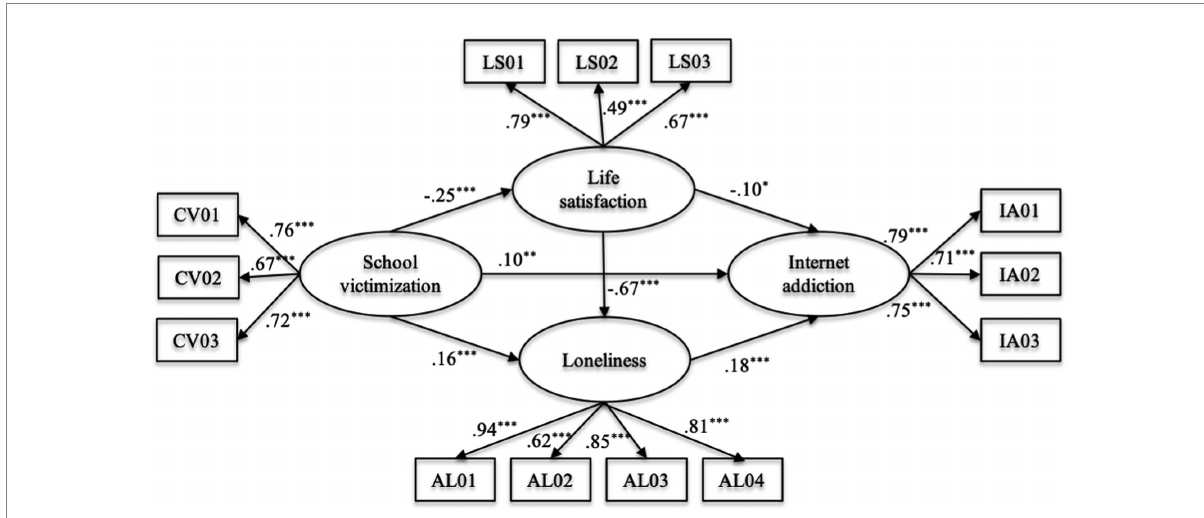
FIGURE 1 The structural model with gender and grade under control ( N = 3,363). Note, the factor loadings were standardized. CV01-CV03, three parcels of victimization; LS01-LS03, satisfaction with friends, school, and self; AL1-AL4, four dimensions of loneliness; IA1-IA3, three parcels of Internet addiction. Form *** p < 0.001, * p <